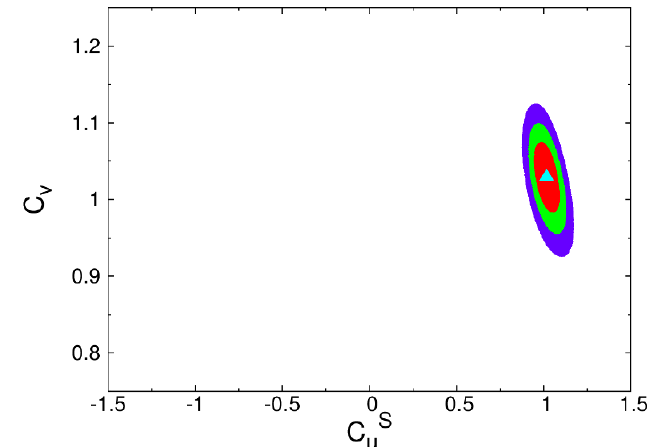
Figure 6 . CPCN2 : the con(cid:12)dence-level regions of the (cid:12)t by varying C S is the same as in (cid:12)gure